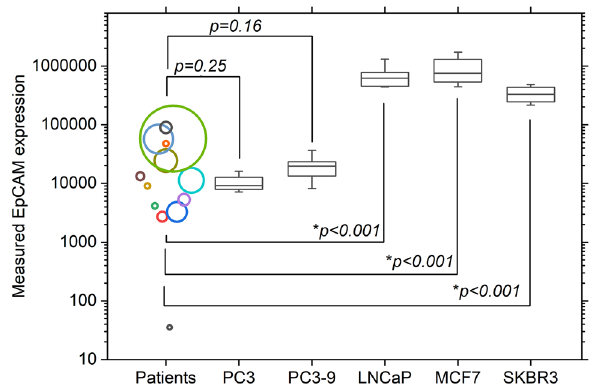
Figure 6. EpCAM expression of CTCs from 13 prostate cancer patients compared to expression measured in five cell lines as cultured at the University of Twente. Circle position indicates median expression per patient and circle size relates to the number of CTCs measured from each patient. Boxes indicate 25–75 percentile with the median as a horizontal line, whiskers indicate 10–90 percentile. * indicates significant difference, p -values as determined using the non-parametric Kolmogorov–Smirnov